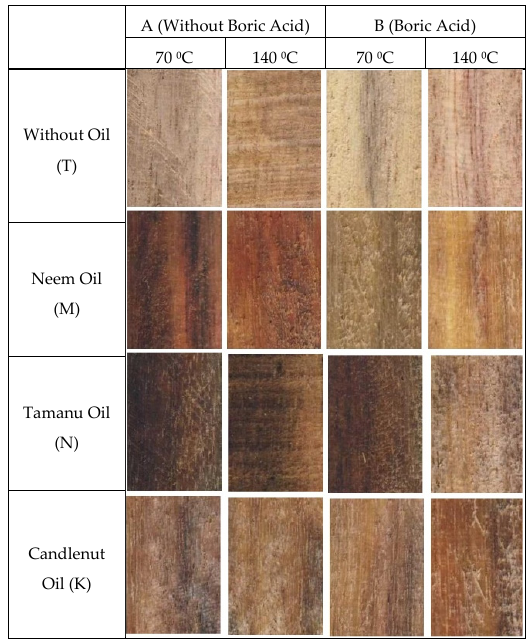
Figure 1. The appearance of manii wood after heating at 70 or 140 °C, and treatments with boric acid (B), without boric acid (A), with neem oil (M), with tamanu oil (N), with candlenut oil (K), and without oil (T).